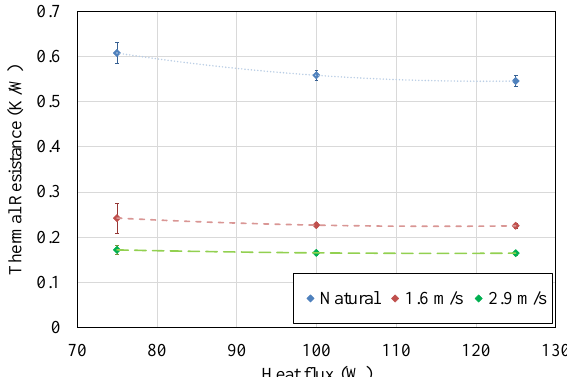
Figure 4. Thermal resistance per thermoelectric module of the cold side heat exchanger for different external conditions. Each experiment has been repeated three times and the uncertainties have been calculated according to [50].